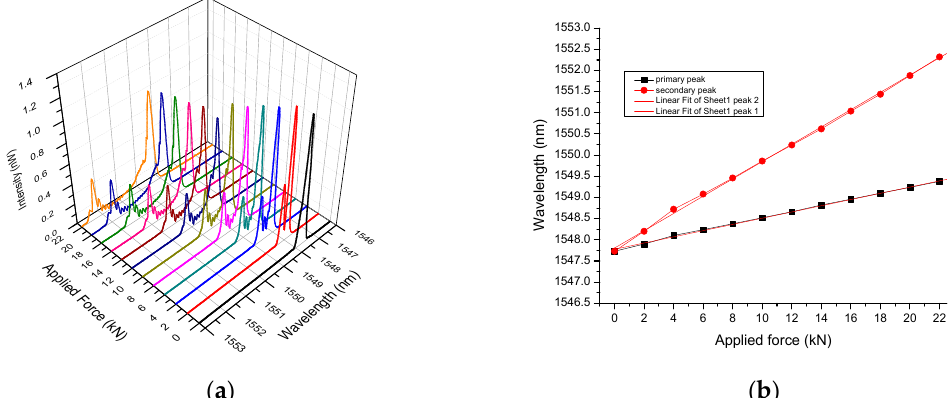
Figure 5. ( a ) 25 mm FBG spectral response with applied force near the crack ‐ tip without composite patch. ( b ) Spectral variations of the FBG maximum intensities of the primary and secondary reflected peaks of with applied force.